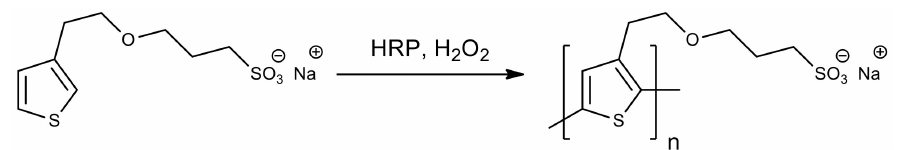
Figure 4. Scheme of enzymatic polymerization of water-soluble (3-thienyl)-ethoxy-4-butyl sulfonate in the presence of horseradish peroxidase